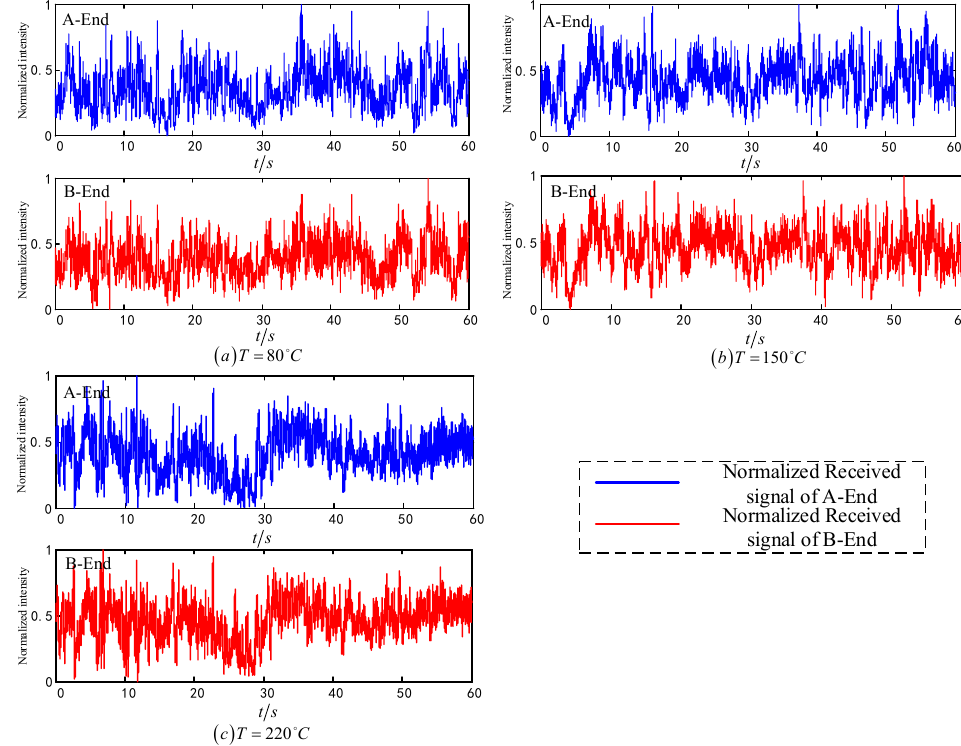
Figure 6. Spot measurement data of two receiving terminals of a bidirectional free-space laser propagation link under different turbulence intensities: ( a ) T = 80 ◦ C weak turbulence, ( b ) T = 150 ◦ C moderate turbulence, ( c ) T = 220 ◦ C strong turbulence.